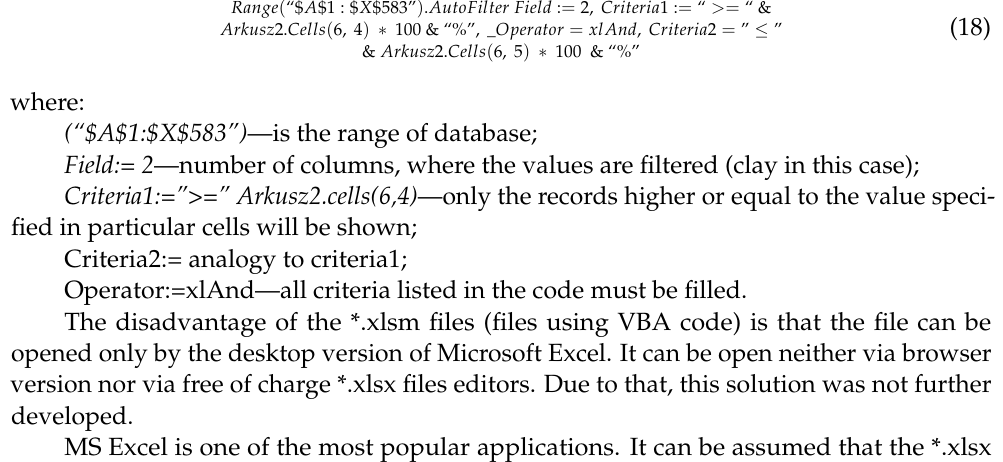
Figure 11. Example of Excel formula used before naming the ranges and using tables.